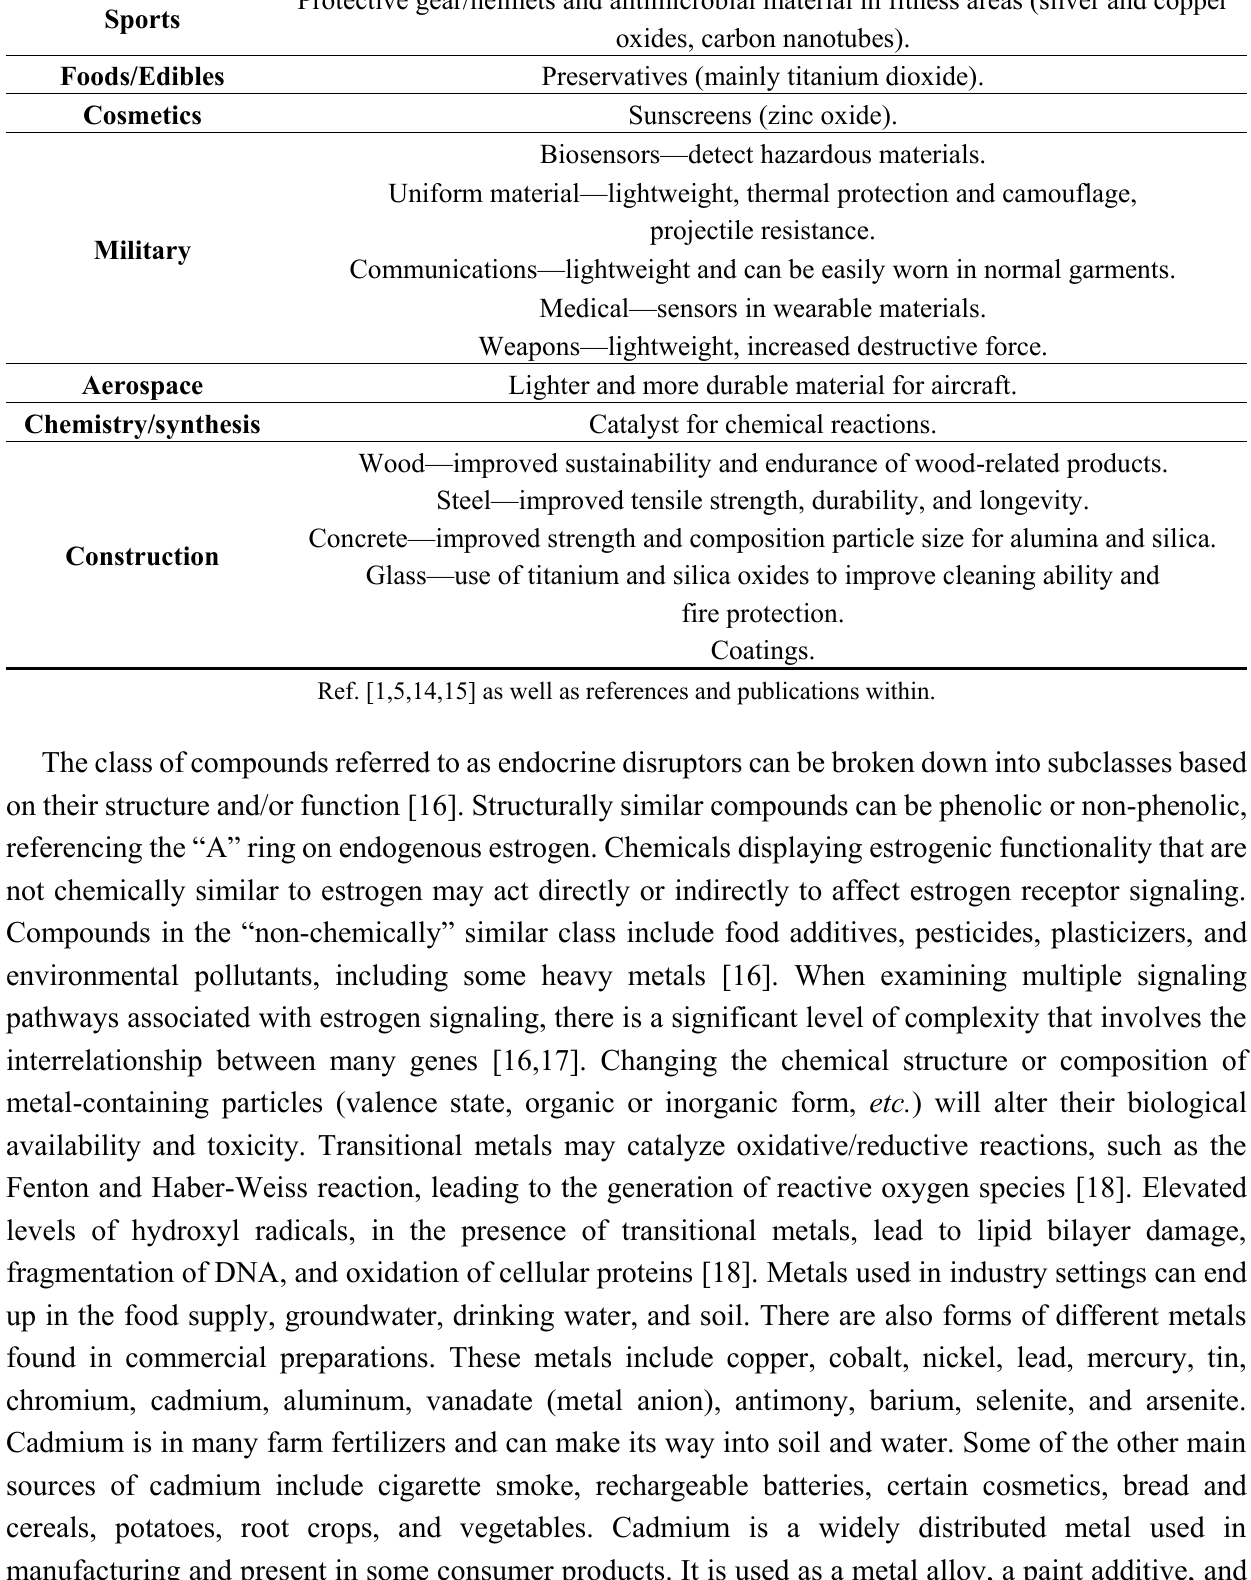
Table 1. Examples of commercial nanomaterial use, and the products impacted by nanomaterials. Uses Material Ceramics and scratch-resistant